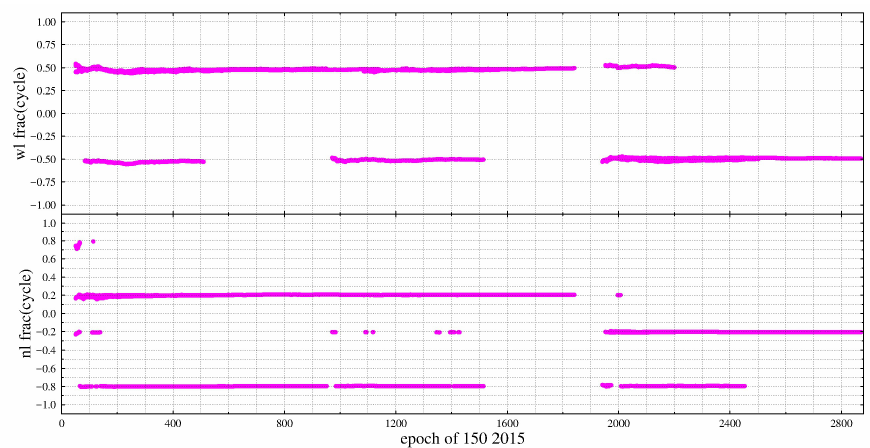
Figure 1. The fractional parts of WL and NL DD ambiguities for GEO and non-GEO satellites at zero-baseline ZIM2-ZIM3. Table 4. Frequency 1 and 2 all with half-cycle jump (Unit: cycle).